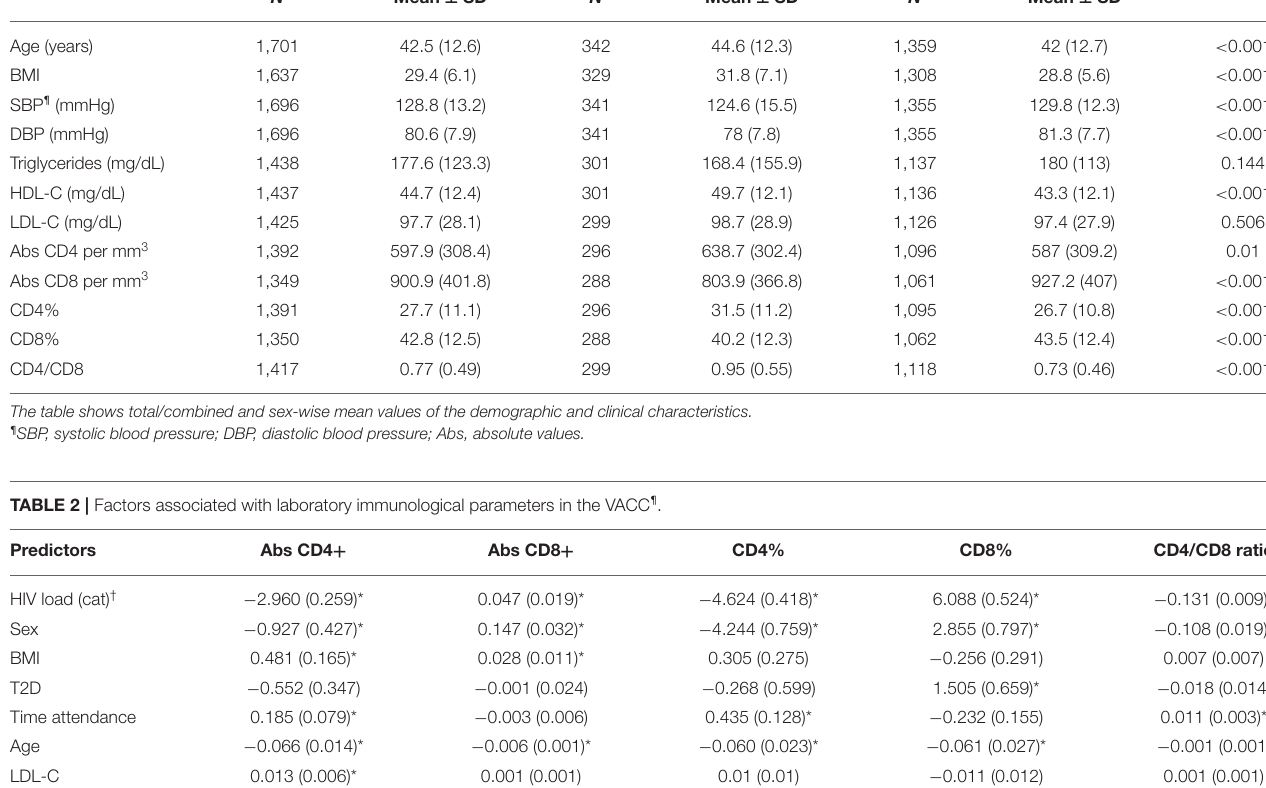
TABLE 1 | General description of the Valley AIDS Council Cohort (VACC). Variables